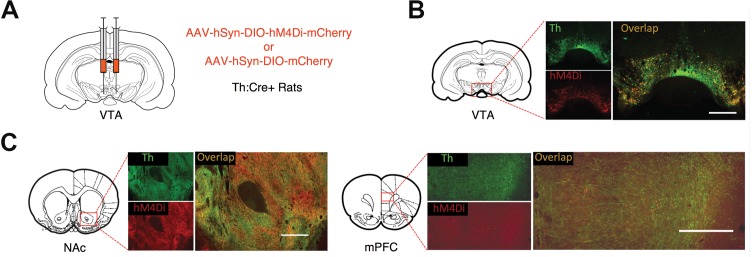
DREADD expression in Th:Cre +rats.(A) Th:Cre+ rats received bilateral injections of AAV-hSyn-DIO-hM4Di-mCherry or AAV-hSyn-DIO-mCherry in the VTA. (B) Representative expression of the mCherry-tagged inhibitory DREADD hM4Di (red) in VTA Th positive neurons (green) of Th:Cre+ rats, as well as in neuronal terminals (C) projecting to the nucleus accumbens (NAc) and medial prefrontal cortex (mPFC). Scale bar is 500 µm.